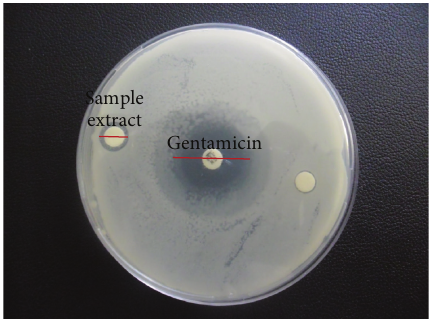
Figure 3: Inhibition zones of phenolic extracts and antibiotic (Gentamicin) against Pseudomonas aeruginosa ATCC 27853.